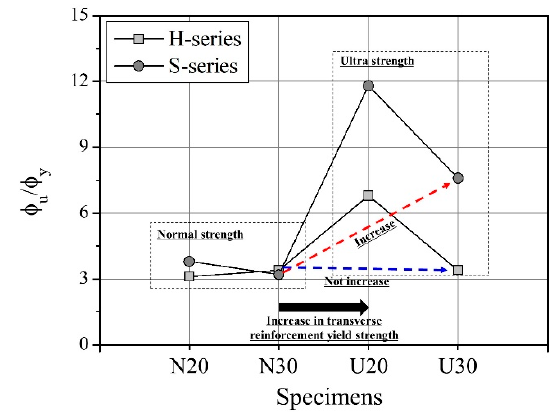
Figure 9. Ductility factors of specimen. Table 3. Previous studies of plastic hinge length for RC columns